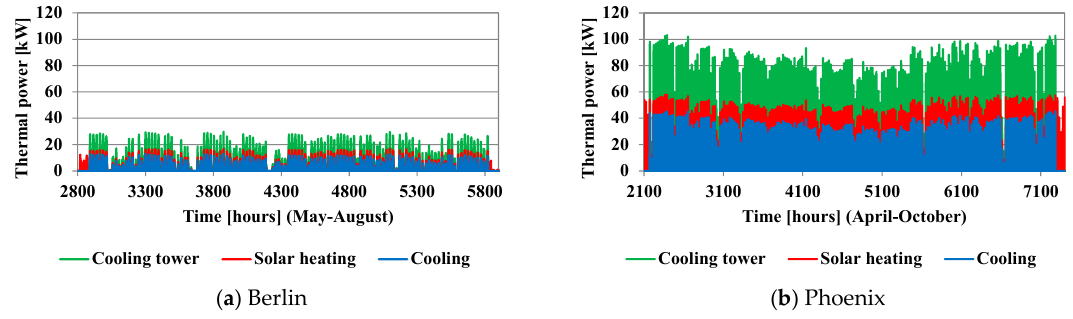
Figure 21. The main components of the SFACS thermal energy balance.